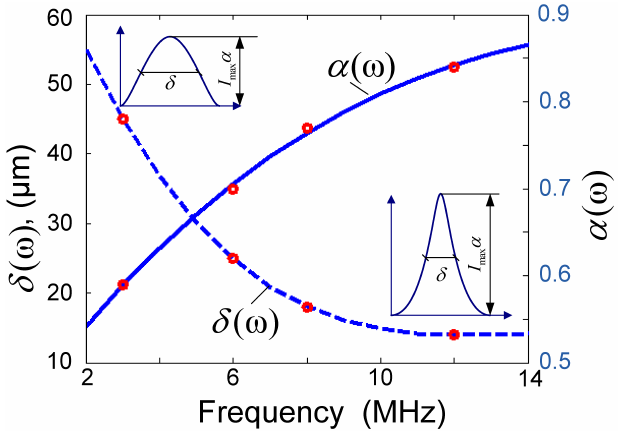
Figure 7. Curves of α ( ω ) (blue line) and δ ( ω ) (dashed line), together with α ( n = 1 .. 4 ) (red circles) taken from Table 1.